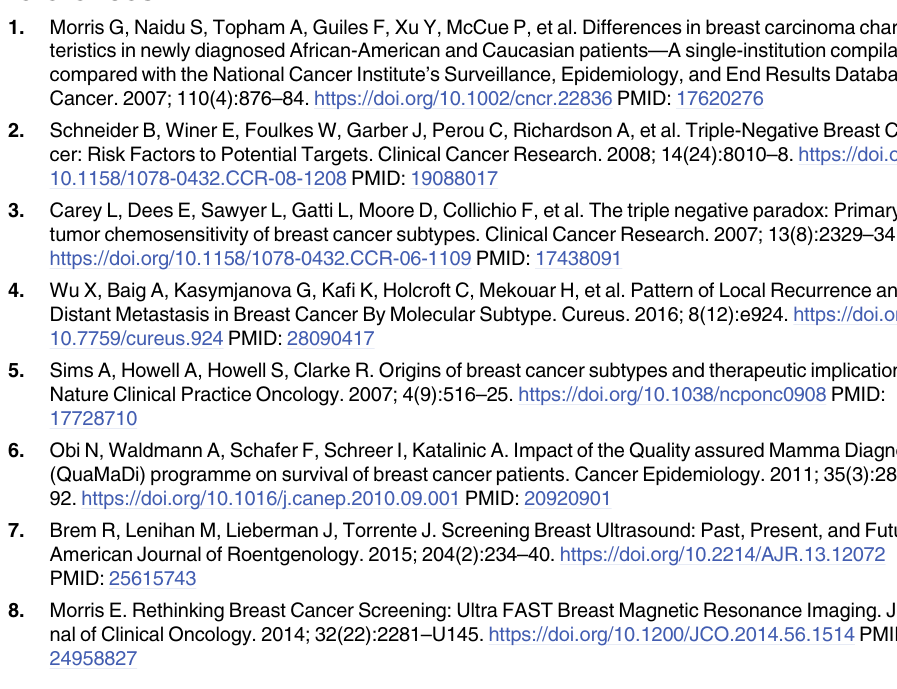
S2 Table. Absorbance ratios of healthy control and TNBC